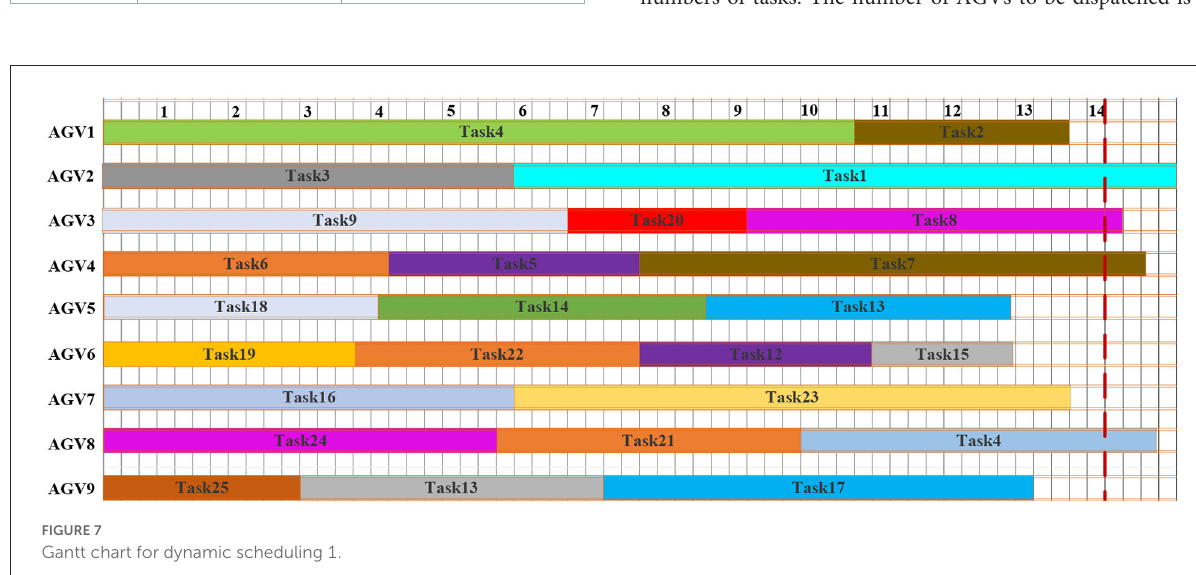
FIGURE7 Gantt chart for dynamic scheduling 1.